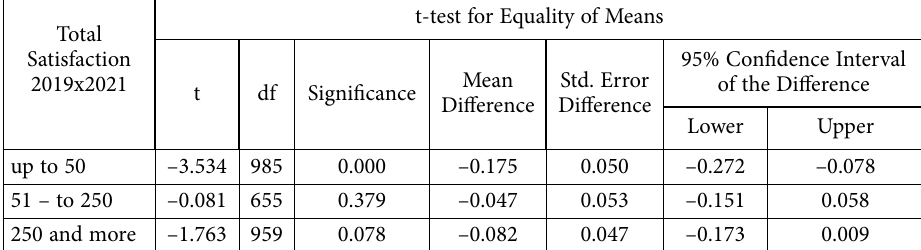
Table 4. T-test and P values for Total Satisfaction by firm size from 2019 to 2021 (source: own processing)